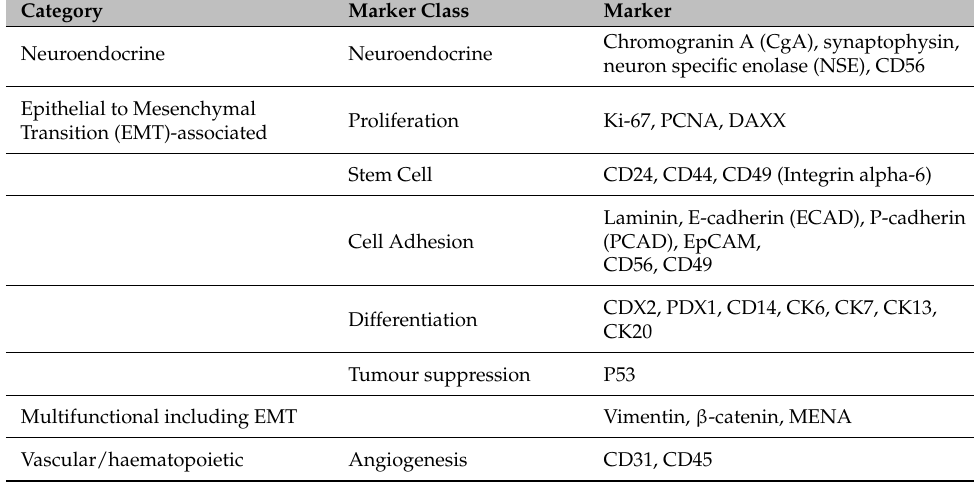
Table 4. List of marker categories, classes and